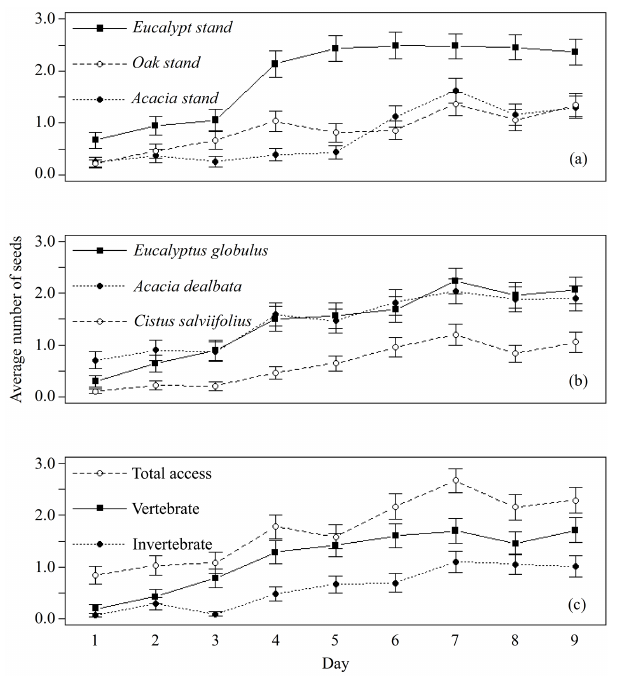
Figure 1. Average daily number of seeds used (missing, eaten, elaiosome detached) per feeder ( ± SE), from a total of five seeds. Data pooled for each day by (a) study site, (b) seed species and (c) feeder